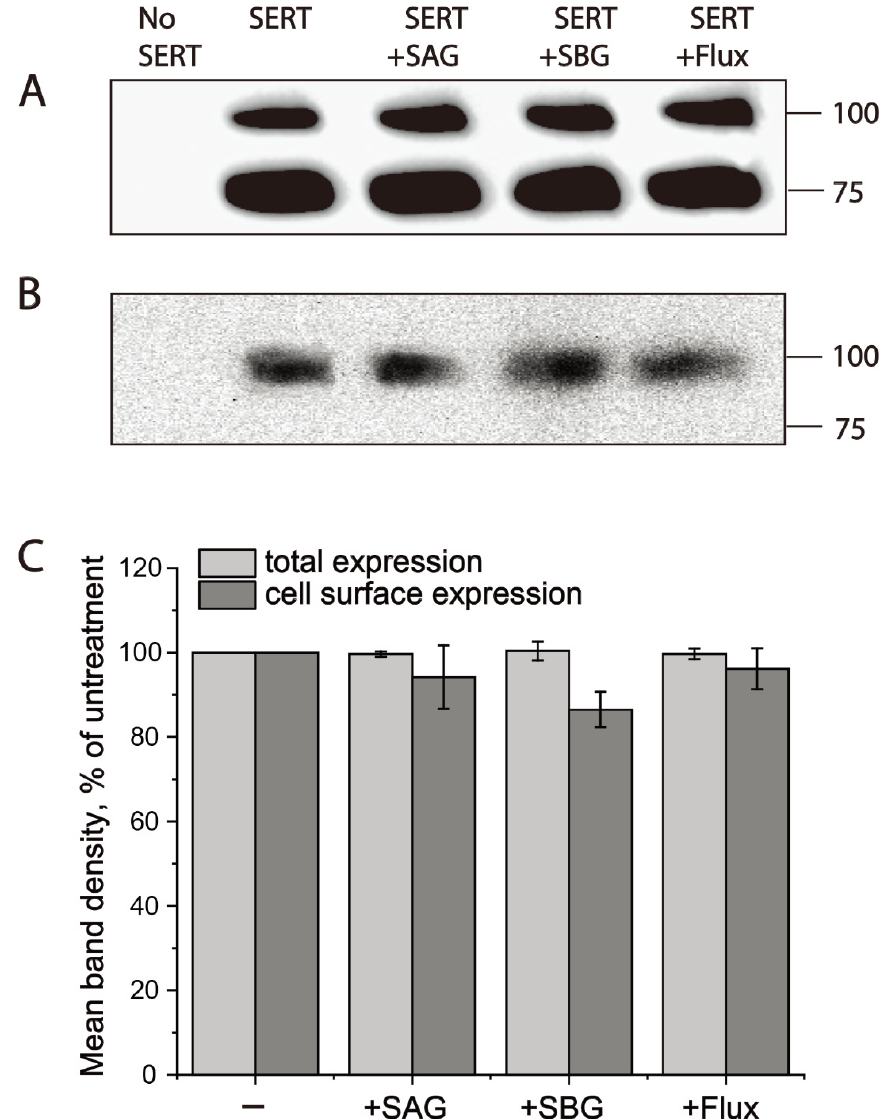
Figure 5. Both SAG and SBG did not alter hSERT expression. Cells expressing hSERT-Flag treated without or with SAG (2 × K i , 10 µ M), SBG (2 × K i , 16 µ M), or fluoxetine (10 µ M) at room temperature for 10 min. After being labeled with NHS-SS-biotin at 4 °C for 30 min, cells were lysed with lysis buffer. Small portion of lysates analyzed for total hSERT-Flag expression. Cell-surface labelled proteins in the residual solution were captured with streptavidin–agarose and subjected to Western blotting analysis for hSERT-Flag cell surface expression, as described in Section 4. ( A ) Representative blot of total hSERT-Flag expression. ( B ) Representative blot of hSERT-Flag cell surface expression. ( C ) Quantitative analysis for effects of SAG and SBG on hSERT-Flag expression. Graph is a combination of three experiments. All error bars represent SEM.